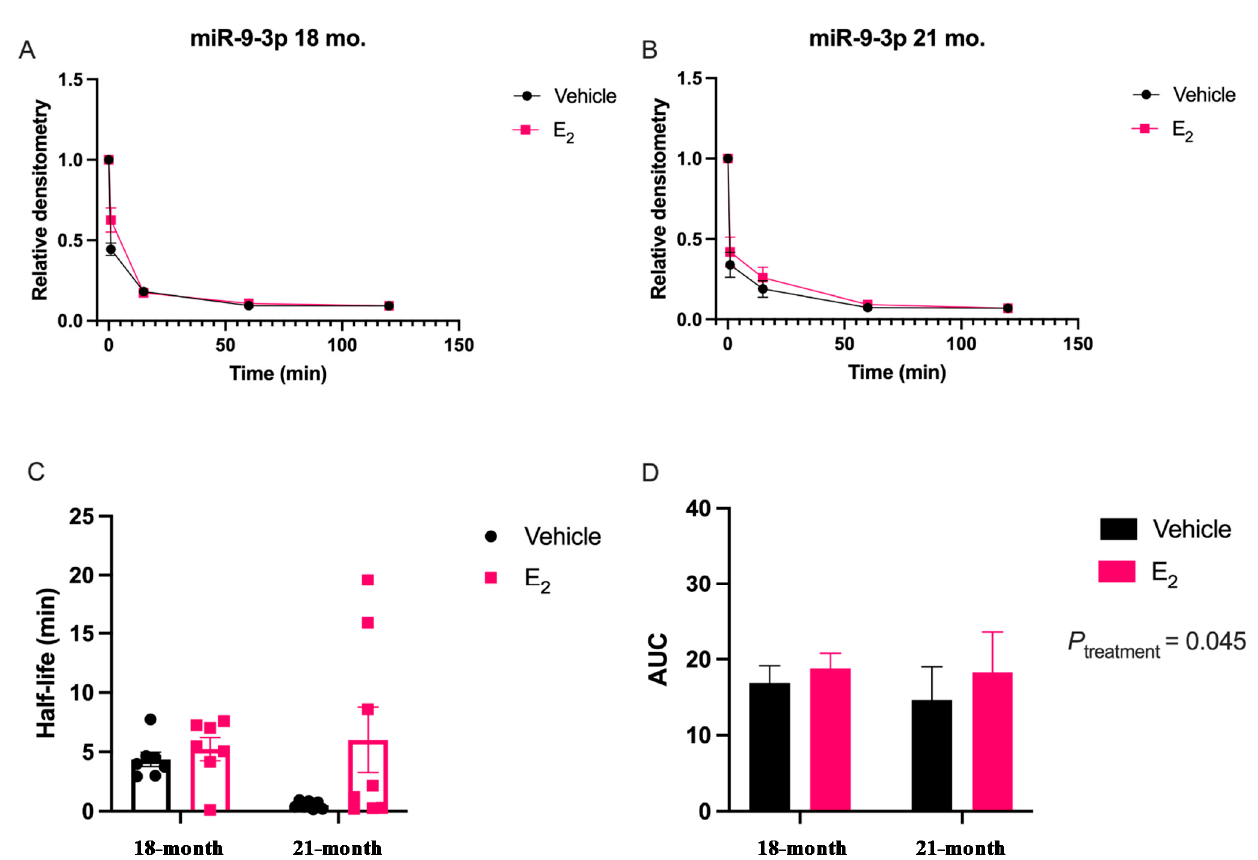
Figure 4. E 2 treatment increased miR-9-3p stability in the paraventricular nucleus of the hypothalamus in a rat model of menopause. Aged female rats were ovariectomized at 18 months and treated with E 2 at 1 or 12 weeks following OVX. miRNA degradation assays were performed using brain tissue lysate isolated from the PVN of the hypothalamus. ( A ) Scatterplot of normalized densitometry values analyzed from microradiographs and fit with a non-linear exponential decay function in 18-month or ( B ) 21-month-old animals (black line = vehicle; red line = E 2 ; N = 8/group). ( C ) Mean half-life and ( D ) area under the curve (AUC) of miR-9-3p calculated from best-fit exponential decay functions. Results are represented as mean ± SEM ( N = 8/group) and analyzed using two-factor ANOVA for Age and Treatment. Significance was noted when p < 0.05. Significant main effects of factors are noted as P subscript .